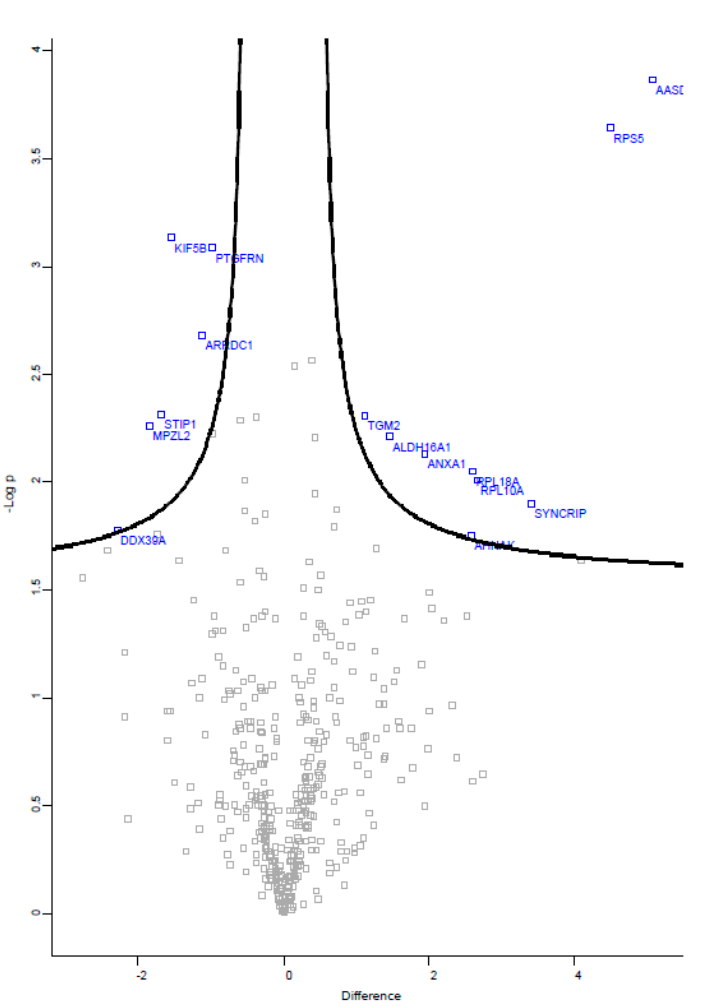
Figure 4. Volcano plot of proteins identified in SW480 cells-derived exosomes. Blue dots are proteins with significant fold changes identified in the exosomes of FTS-treated cells.